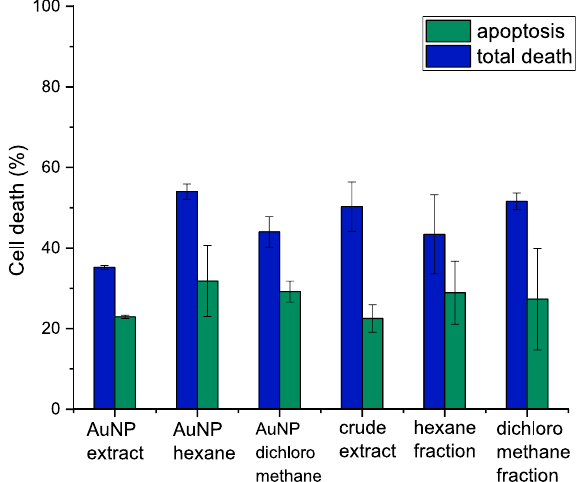
Figure 10. Percentage of apoptosis in relation of total PC-3 cell death obtained by Flow